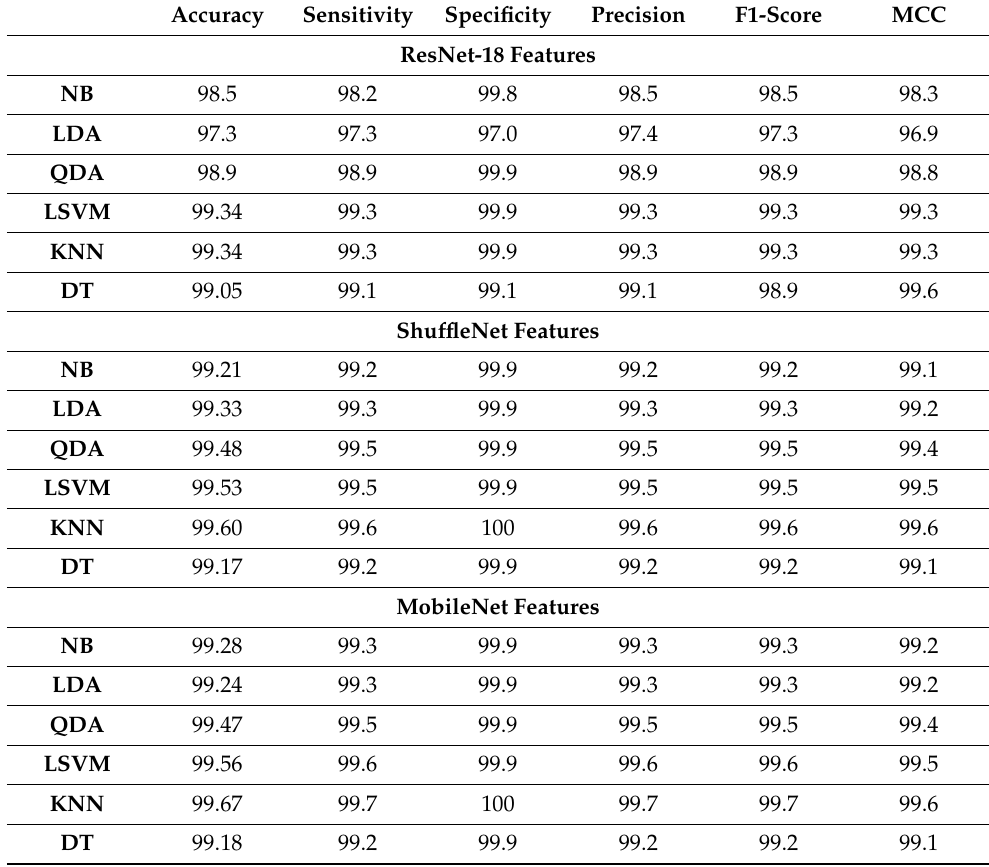
Table 2. The classification results (%) obtained by the individual deep features of ResNet-18, Shuf- fleNet, and MobileNet. Accuracy Sensitivity Specificity Precision F1-Score MCC ResNet-18